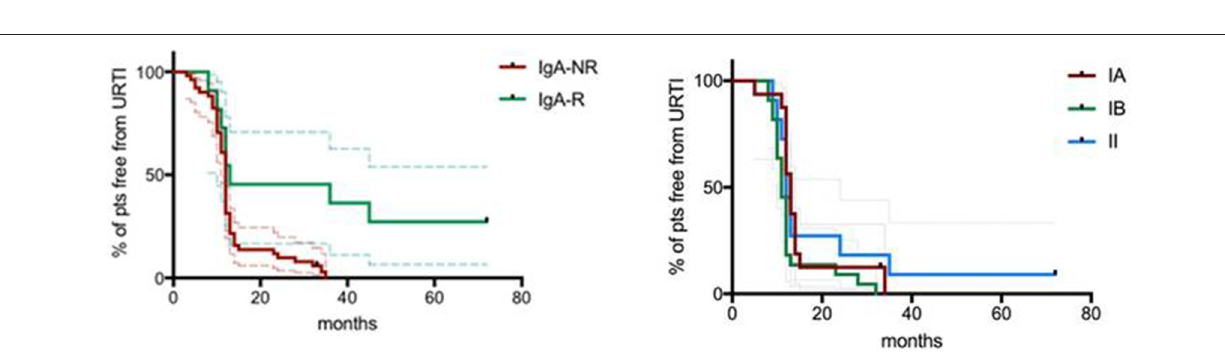
FIGURE 4 | Percentage of CVID patients free from URTI grouped as IgA-NR and IgA-R (left panel) and percentage of CVID patients free from URTI grouped according to the Freiburg classification (right panel). URTI: upper respiratory tract infections. Dashed lines represent 5 ◦ th and 95 ◦ th